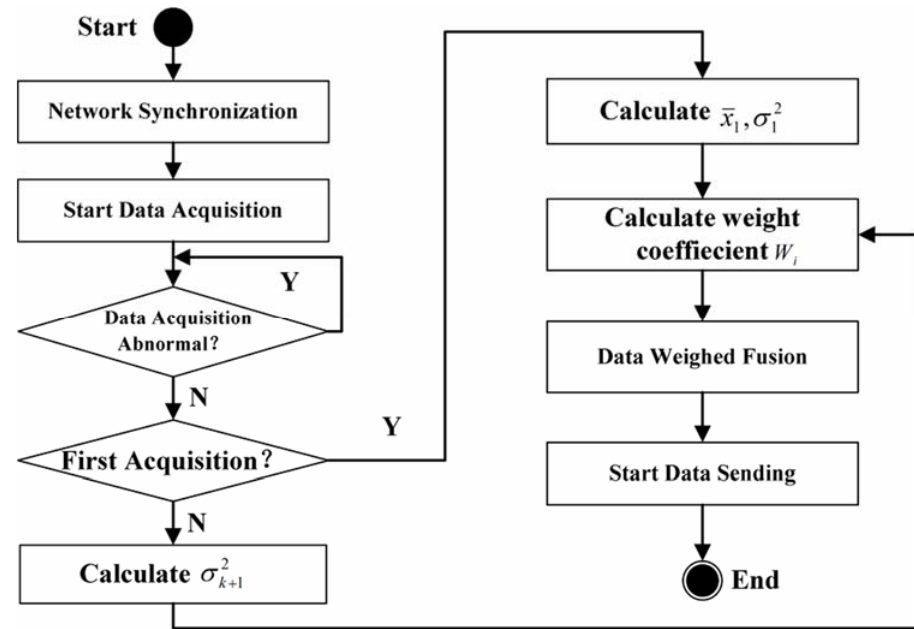
Figure 2. Flow chart of the optimal weighted data fusion in the sensor